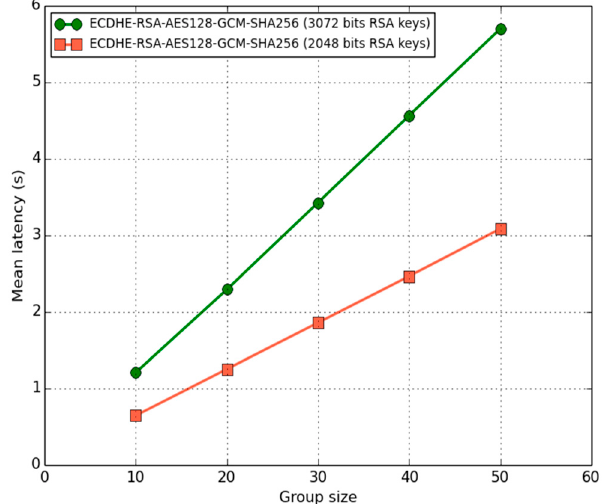
Figure 7. Latency (in seconds) for group key generation and distribution in a leave operation. Comparison experimental results as a function of the cardinality of set of remaining inverters and RSA-keys security levels: 112-bit vs. 128-bit.